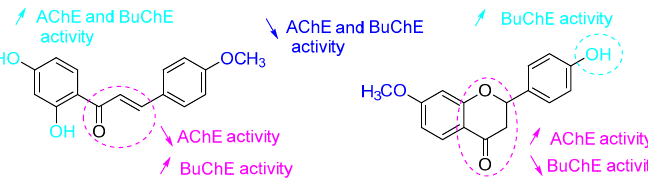
Figure 4. Structure/activity relationships established for antioxidant activity. Figure 4. Structure / activity relationships established for antioxidant